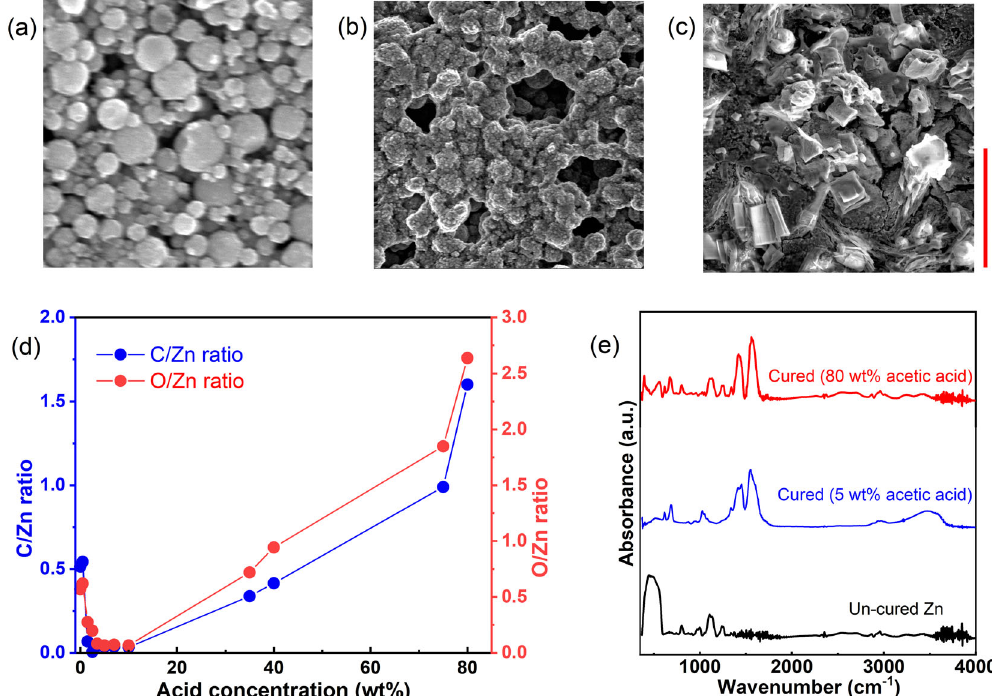
Fig. 3 Characterization of the curing process. a – c SEM topography images (scale bar: 1 µm): ( a ) un-cured printed Zn; ( b ) Zn sample cured by 5 wt% acetic acid ink; ( c ) Zn sample cured by 80 wt% acetic acid ink. d EDX analysis of atomic percentage for cured and un-cured samples. Lines are guides for the eye. e Shows the FTIR absorbance spectrum of the printed-Zn-NPs, cured (5 wt % and 80 wt%), and uncured